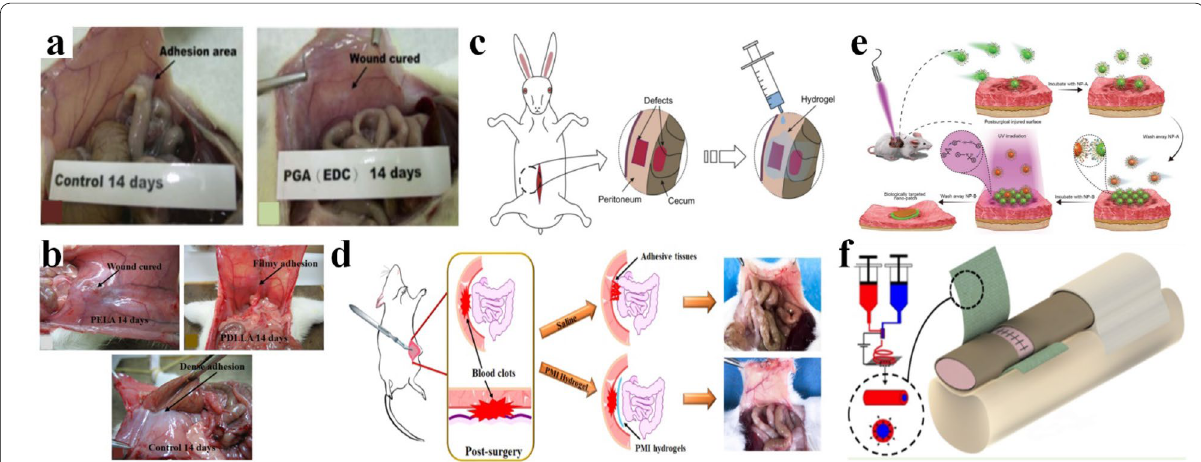
Figure 7 Surfaces to prevent postsurgical tissue adhesion: ( a ) PGA-EDC, ( b ) PELA, ( c ) PCLA-PEG-PCLA, ( d ) H-bonding supramolecular hydrogels, ( e ) pCNP, and ( f ) electrospun nanofibrous